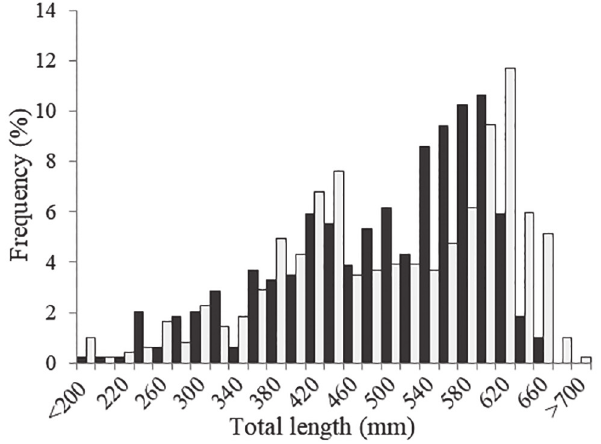
Fig. 2 . Total length frequency distribution of males (dark bars, n= 488) and females (light bars, n = 486) of Atlantoraja cyclophora